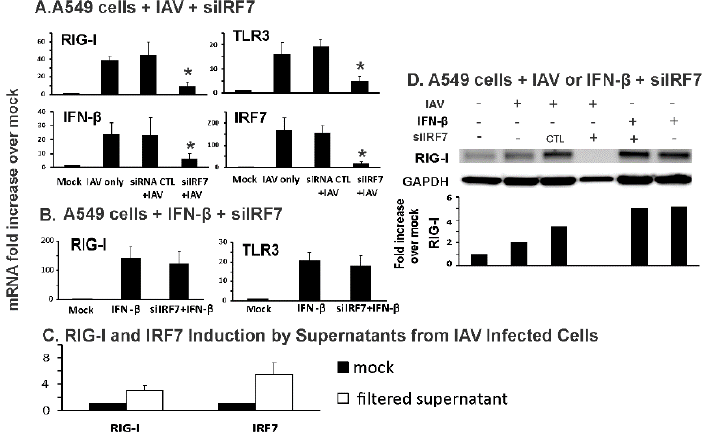
Figure 5. Knockdown of IRF7 inhibited influenza-mediated RIG-I induction and innate responses in human alveolar epithelial cells. A549 cells were transfected with IRF7 siRNA for three days. Then, the cells were infected with ( A ) IAV PR8 at the MOI of 0.2 for 24 h or ( B ) 500 U / mL of IFN- β for 6 h. Total RNA was extracted and mRNA expression was assessed by qRT-PCR. Data were expressed as the means ± SEM from three separate experiments. Statistical significance was determined by ANOVA. * denotes significant di ff erence compared to data from the siRNA CTL + IAV infected group, p < 0.05. ( C ) Supernatants from IAV infected cells stimulated RIG-I / IRF7 expression in uninfected cells. Supernatants were collected from IAV infected cells after 24 h poi. Then the supernatants were filtered to remove IAV using a 100 K MW filter (Amicon). The filtered supernatants were added to A549 cells and changes in RIG-I / IRF7 mRNA were assessed by qRT-PCR. ( D ) RIG-I protein in A549 cells was detected by immunoblotting. The immunoblot shown is representative of three separate experiments, with quantitation of that result depicted below the image.